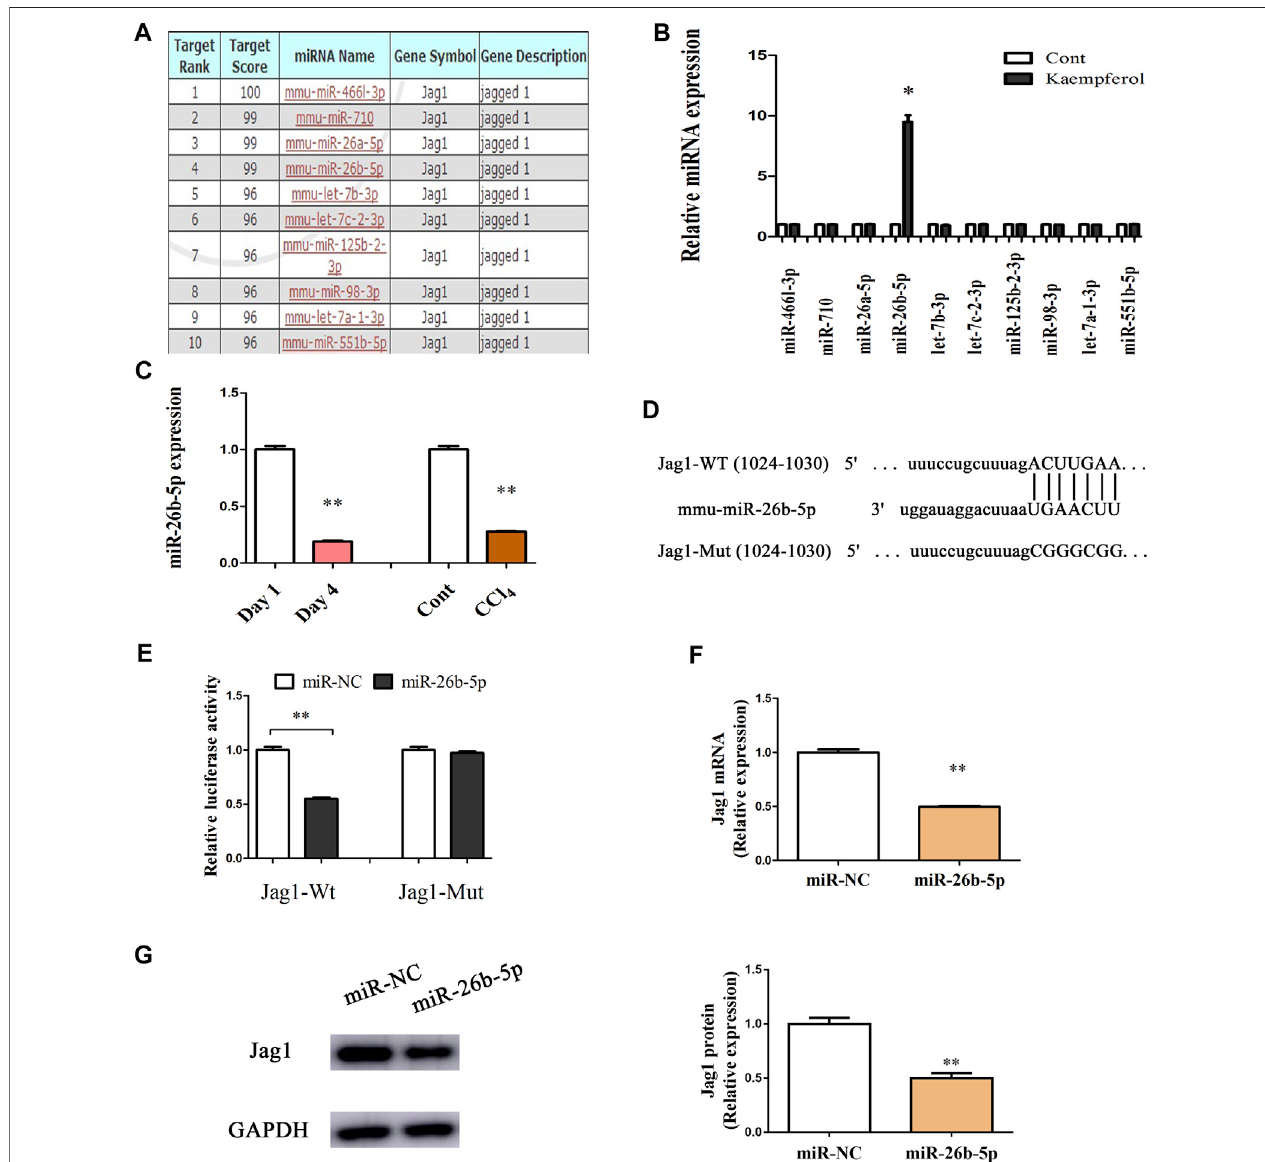
FIGURE5| Jag1isatargetofmiR-26b-5p. (A) 10predictedmiRNAswiththehighesttargetscorewereshowninbioinformaticsanalysis(miRDB). (B) miR-26b-5p wasenhanced incellswithkaempferol. (C) miR-26b-5plevel invitro and invivo . (D) miR-26b-5p-bidingsitesinthe3 ′ UTRofJag1mRNAbasedonmiRDBsoftware. (E) Relative luciferase activities of luciferase reporters bearing wild-type or mutant Jag1 were analyzed 48 h following transfection with the indicated miR-26b-5p mimics or miR-NC in HEK293T cells. Jag1 mRNA (F) and protein (G) expression in cells with miR-26b-5p. * p < 0.05, ** p < 0.01 compared with the control.